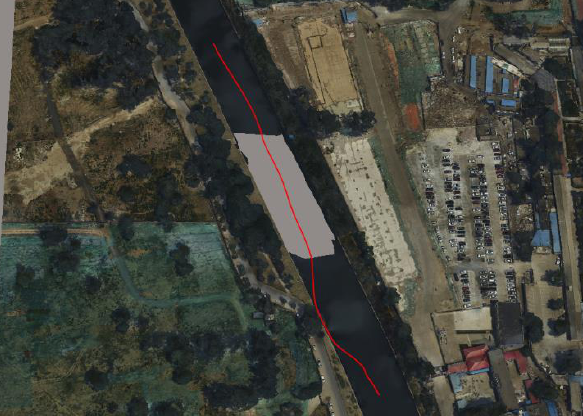
Figure 5. elevation, error distribution map